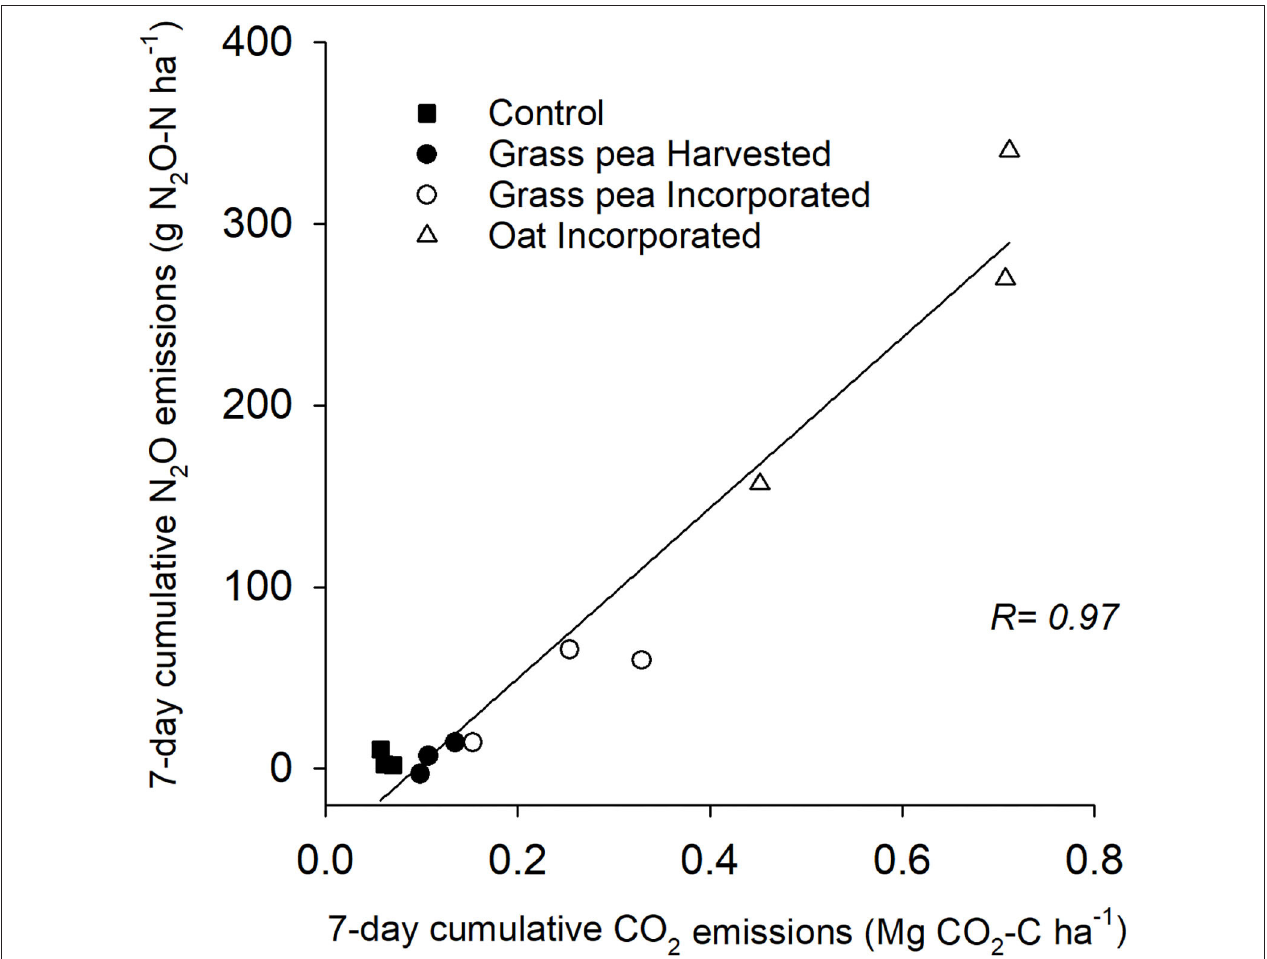
FIGURE 3 | Correlation of cumulative carbon dioxide (CO 2 ) and nitrous oxide (N 2 O) emissions from individual collars across the treatments during the first 7 days of soil incorporation of cover crop biomass. Pearson’s correlation coefficient ( R ) between the cumulative emissions is